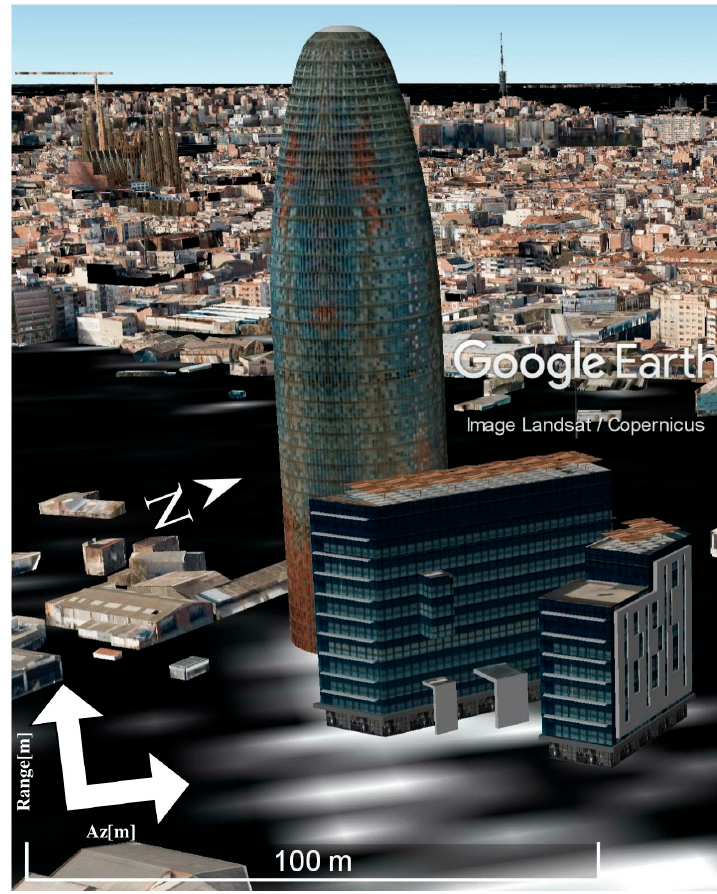
Figure 9. 3D view of the second test area with the SAR image superimposed. Remote Sens. 2016 , 8 , x FOR PEER REVIEW